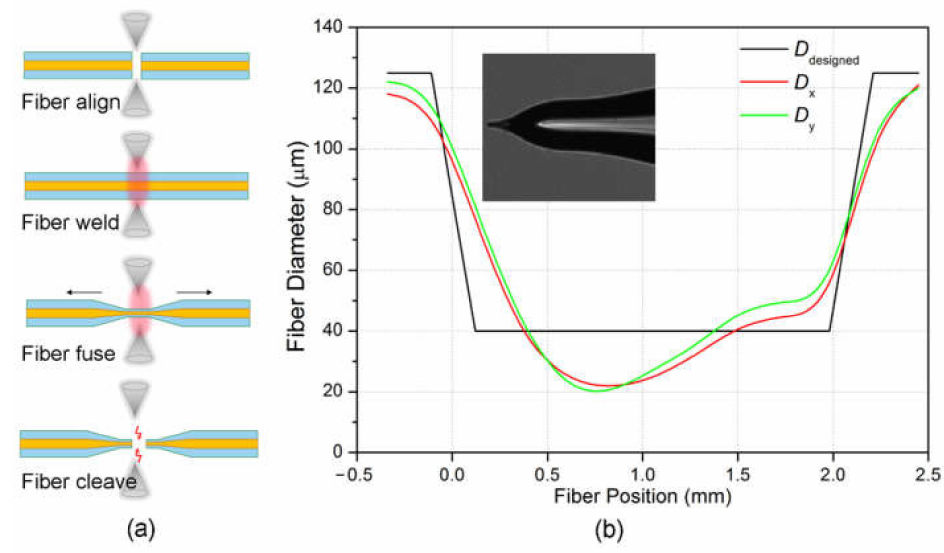
Figure 6. ( a ) Illustration of the tapered fiber fabrication process; ( b ) the pre-set tapered fiber diameter D designed in the splicer and the pulled fiber diameters D x and D y before cleaving. Insertion: the tip end of the optical tapered fiber.